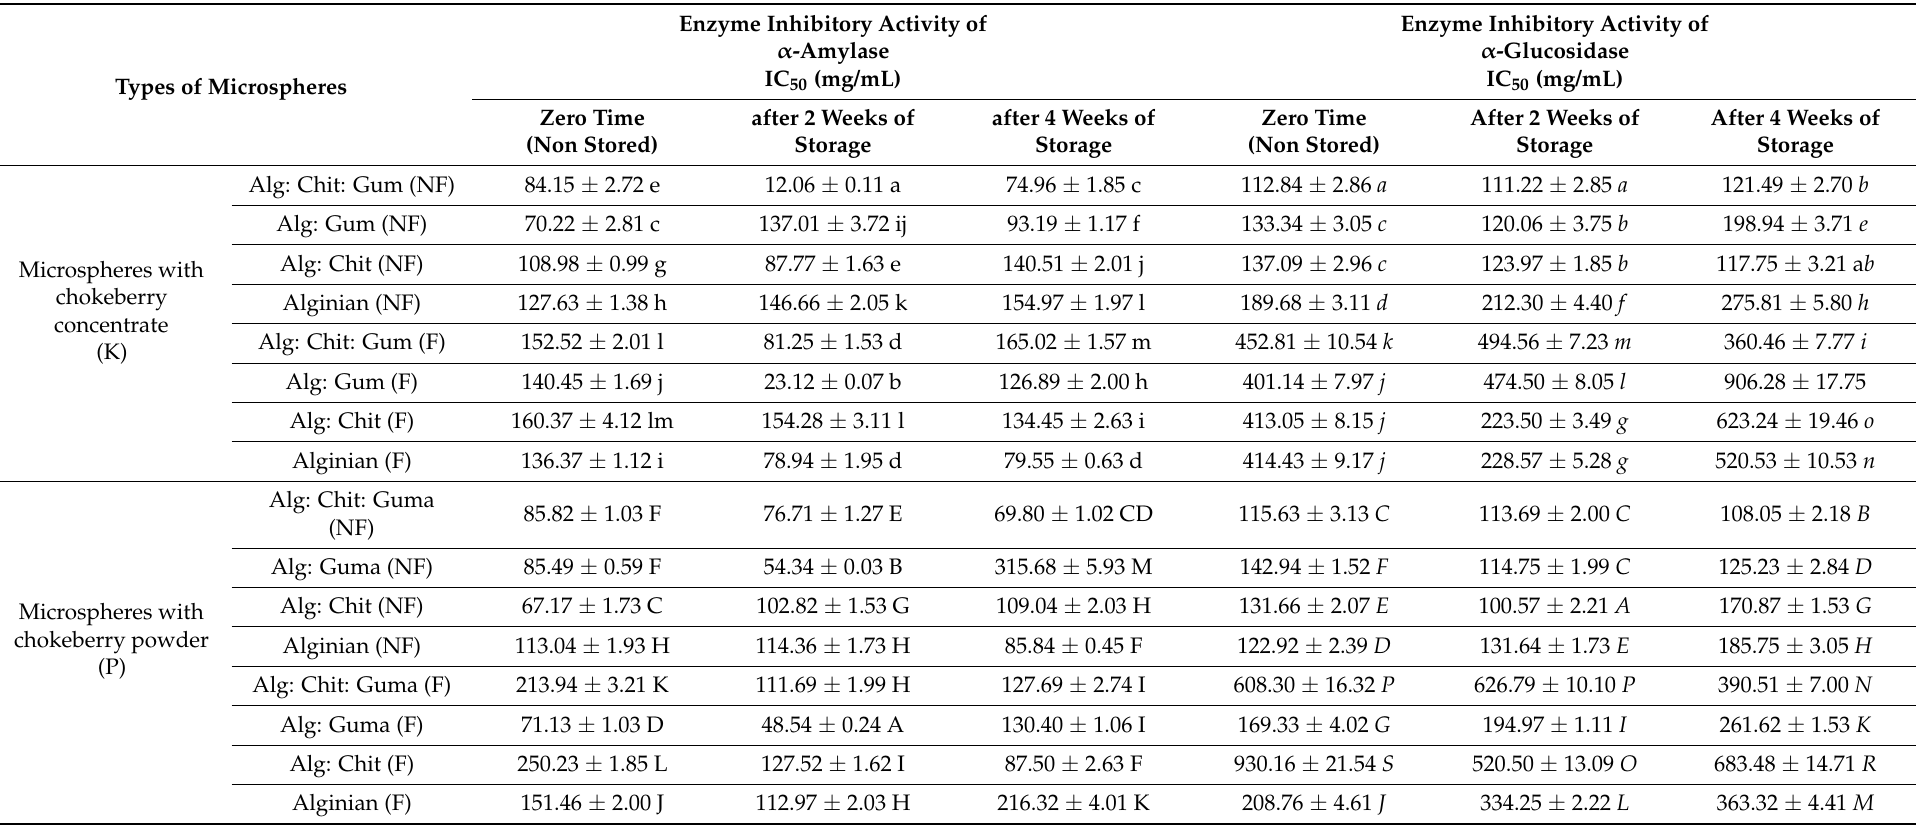
Table 4. Anti- α -amylase and anti- α -glucosidase